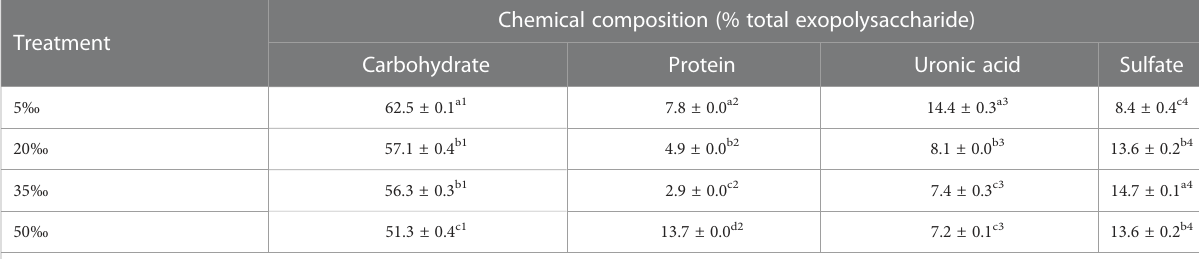
TABLE 2 Chemical composition of Porphyridium purpureum FACHB 806 exopolysaccharide under different salinities.